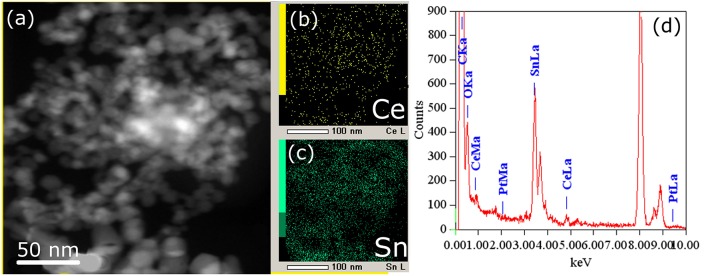
HAADF-STEM image (a) and corresponding EDX-mapping (b,c) patterns (CeL signal is shown in yellow, SnL signal is shown in green) of the Pt/CeSn-600 sample, (d) EDX analysis of the sample composition.